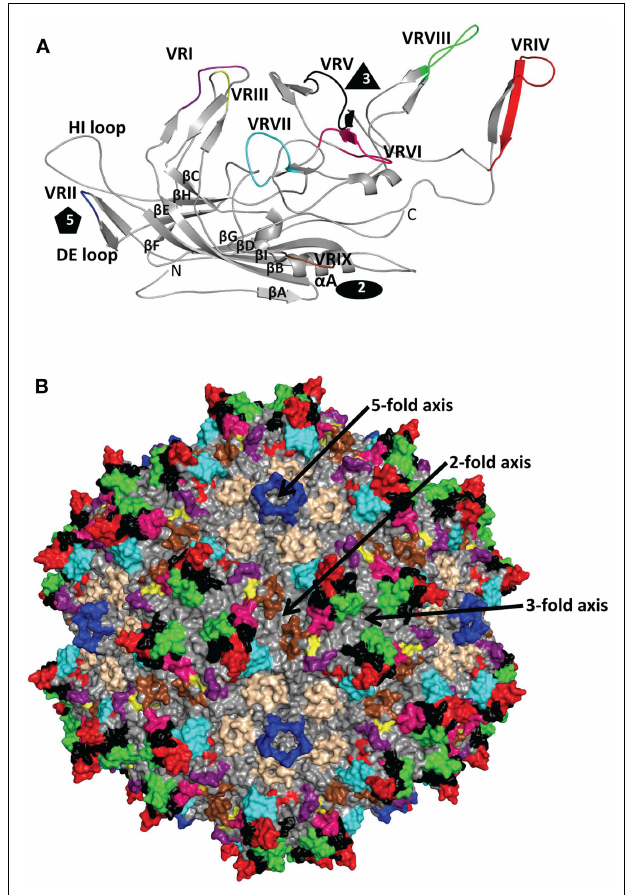
FIGURE 2 |AAV variable regions . (A) A ribbon diagram representation of the ordered overlappingVP3 monomer region of AAV1.The conserved β -barrel core motif ( β BIDG- β CHEF, gray), conserved α A helix, DE loop (between β D and β E), HI loop (between β H and β I),VR-I toVR-IX [defined (26)] are colored; I: purple, II: blue, III: yellow, IV: red,V: black,VI: hot pink, VII: cyan,VIII: green, and IX: brown; and labeled.The approximate positions of the 2-, 3-, and 5-fold axes are indicated by the filled oval, triangle, and pentagon, respectively.The N and C labels are the N- and C-terminal ends of the orderedVP region, respectively. (B) The capsid surface of AAV2 with VR-I toVR-IX colored as in (A) .The approximate icosahedral 2-, 3-, and 5-fold symmetry axes are indicated and labeled as in Figure 1 . Both (A) and (B) were generated with the PyMOL program (http://www.pymol.org).